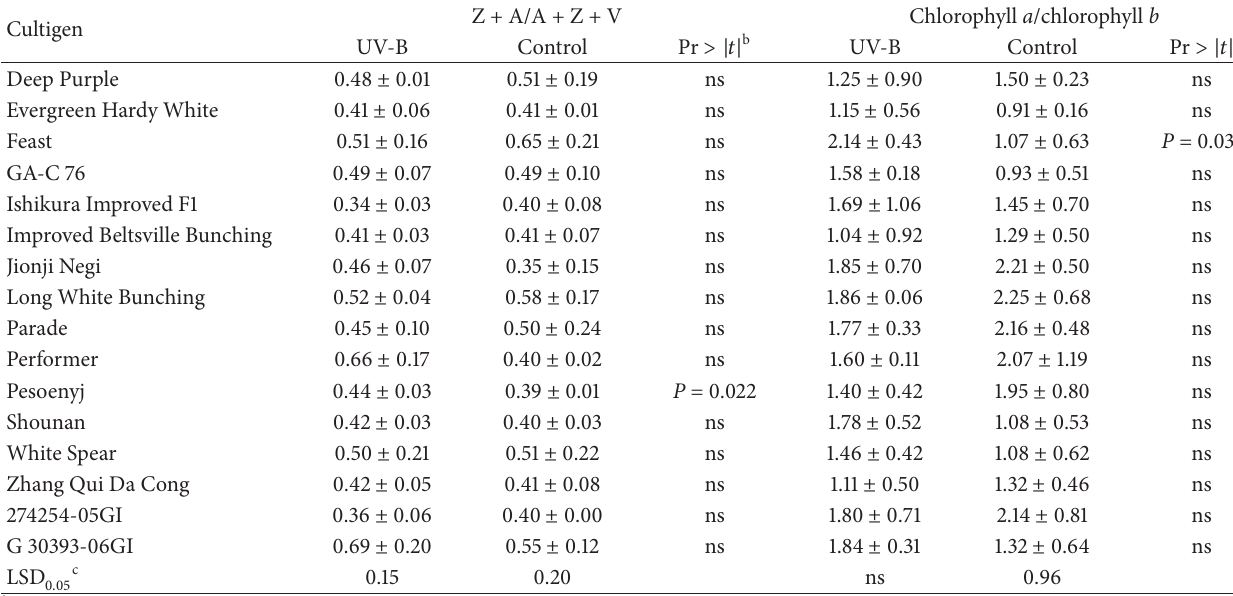
Table 4: Mean values a for the ratio of zeaxanthin + antheraxanthin to zeaxanthin + antheraxanthin + violaxanthin (Z + A/A + Z + V) and the ratio of chlorophyll a to chlorophyll b (chlorophyll a /chlorophyll b ) in shoot tissues for Allium fistulosum L. cultigens grown under